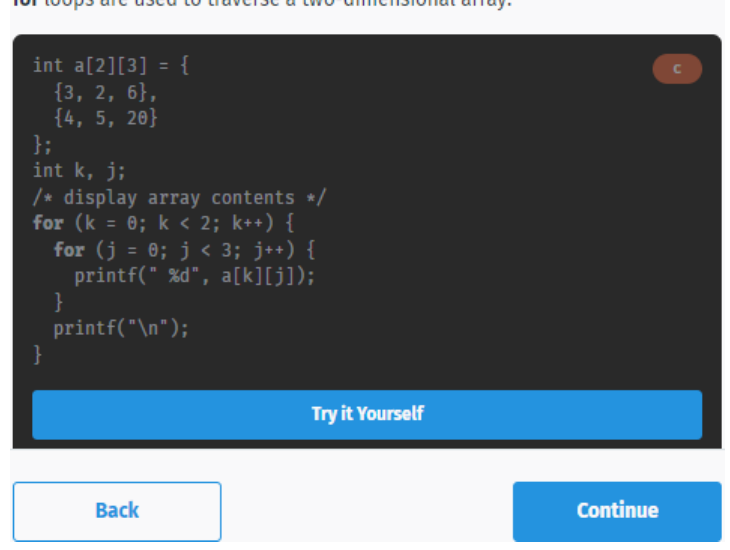
Figure 4: Ability to work with program code in